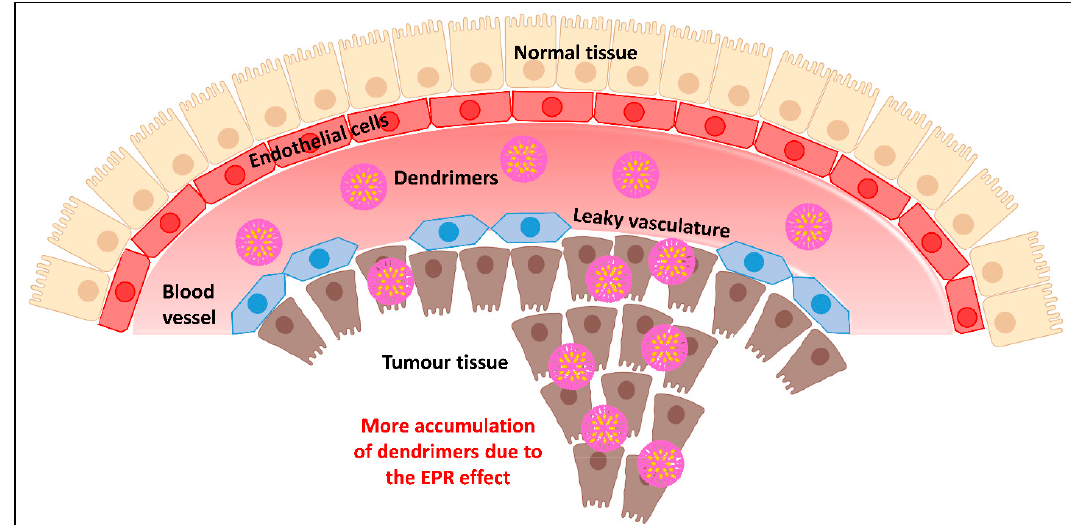
Figure 5. Dendrimer-mediated passive targeting of anticancer drugs.